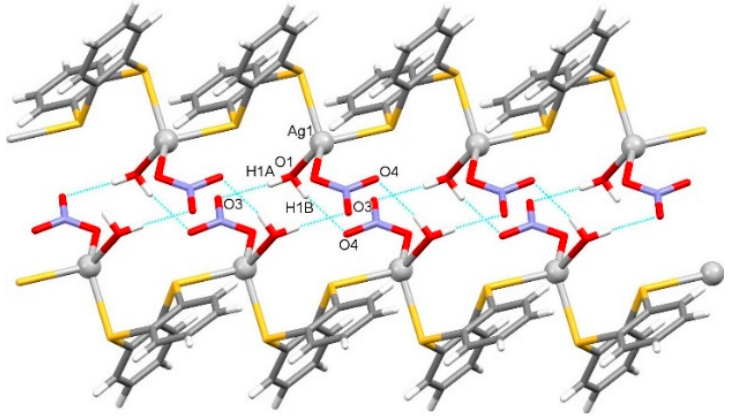
Figure 2. Hydrogen bonded belt in Ag1 . Hydrogen bonds are drawn by dashed blue lines.